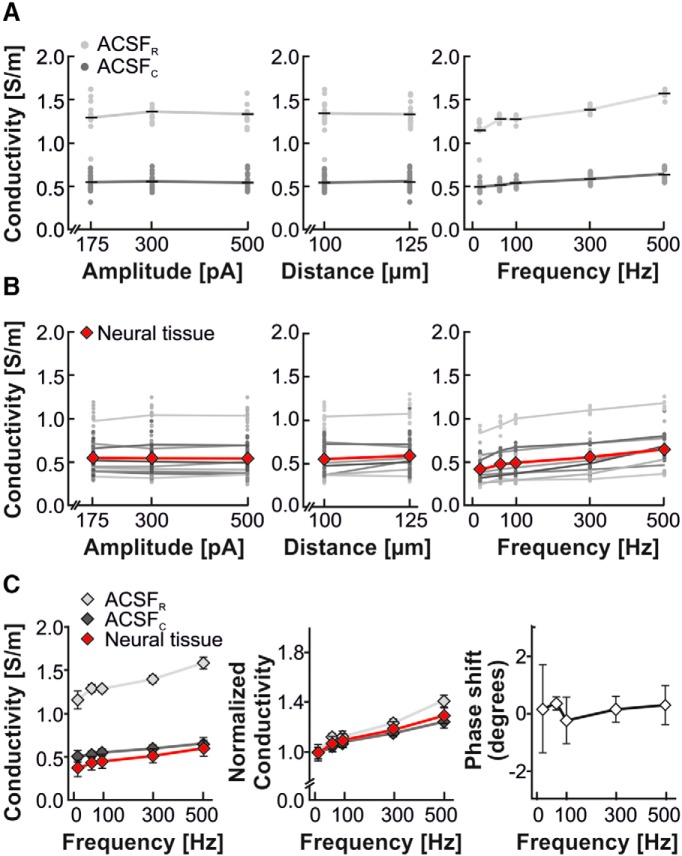
Current amplitude, distance, and frequency dependence of conductivity within ACSF and neural tissue. Conductivities were determined for different current amplitudes (175, 300, and 500 pA), distances between injection and closest recording electrode (100 and 125 µm), and current injections of different frequencies (5, 60, 100, 300, and 500 Hz). A, conductivity (S/m) within ACSF (ACSFR, amplitude n = 2, distance n = 3, light gray) and control ACSF (ACSFC, amplitude n = 4, distance n = 6, black). Parameter-specific frequency dependence is shown for the pooled data of the remaining two parameters. Data are shown as the mean (diamonds) and individual data points (dots). B, conductivity of neural tissue (amplitude n = 18, distance n = 27 recorded in 9 brain slices, mean is plotted in red). C, Comparison of data recorded in ACSF and in cortical neural tissue based on data shown in A and B. Conductivity as a function of frequency for ACSFR (light gray), ACSFC, (dark gray), and neural tissue (red) as absolute values (left) and normalized to the value at 5 Hz (middle). Right, Difference between phases measured in ACSF and neural tissue. Data are reported as the mean ± SEM.